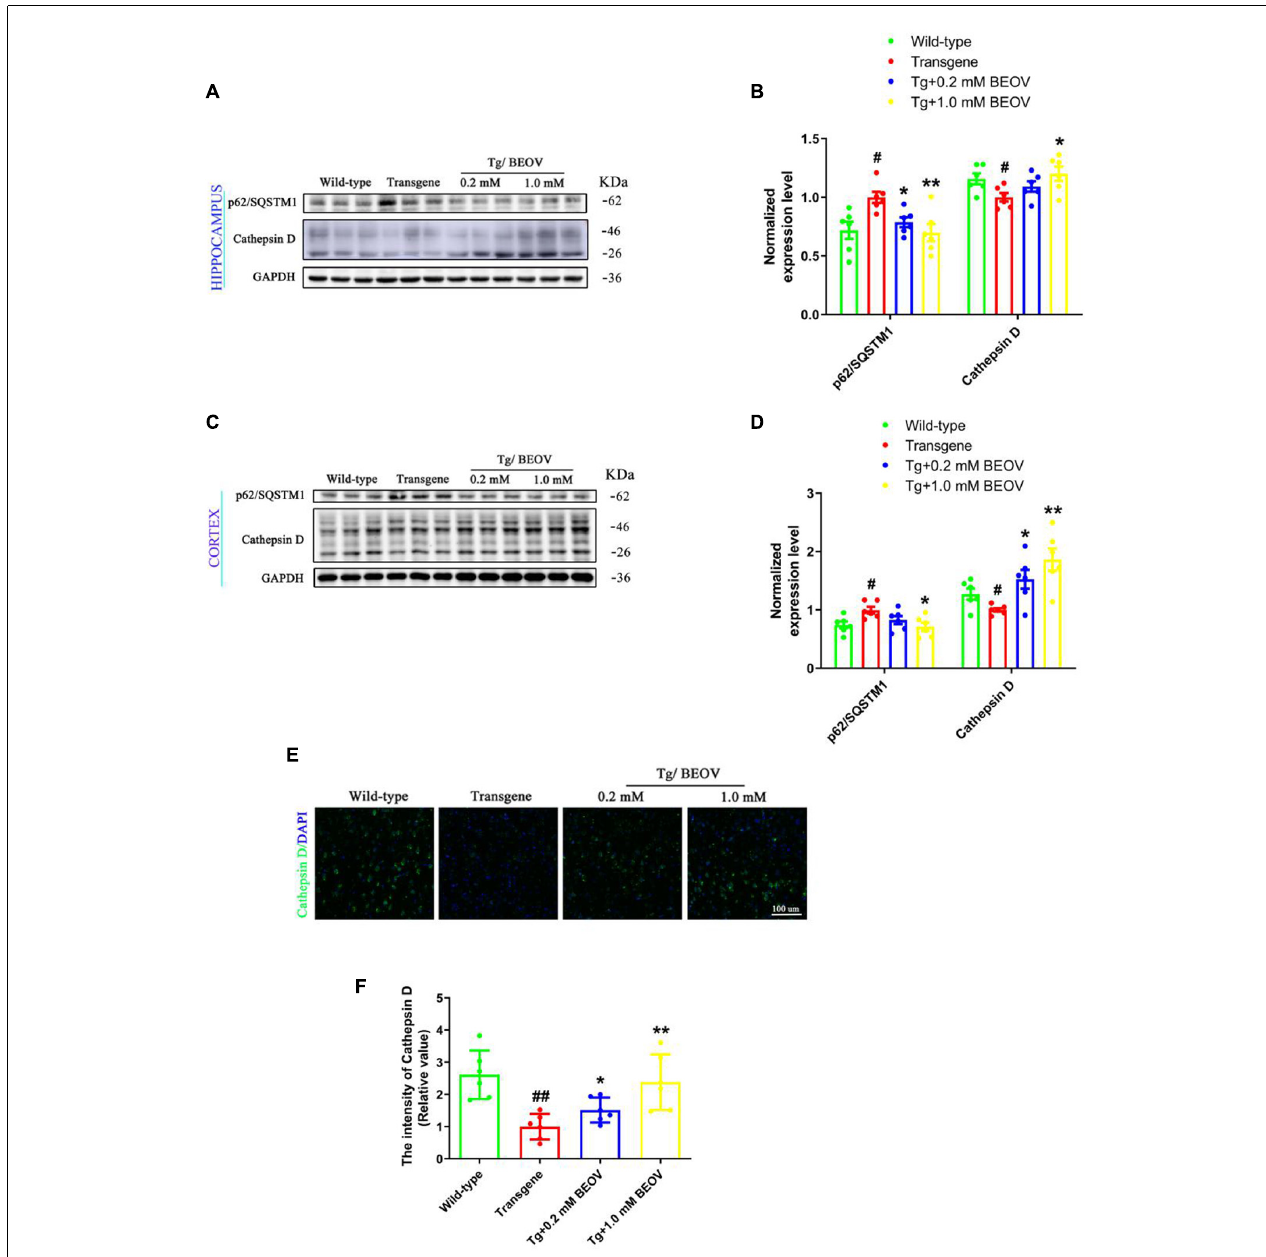
FIGURE 10 | BEOV reduced the p62 levels and increased the Cathepsin D levels. (A,C) Western blot analyses of p62/SQSTM1 and Cathepsin D levels in hippocampus and cortex of WT, APPSwe/PS1dE9, and BEOV-treated APPSwe/PS1dE9 mice. (B,D) Semi-quantification of p62/SQSTM1 and Cathepsin D in mouse hippocampus and cortex. Quantitative results were normalized against the levels of GAPDH. (E) Representative immunofluorescent images of Cathepsin D expression in the cortex. Scale bar: 100 µ m. (F) The staining intensity of Cathepsin D was quantified and six sections from different mice in each group were analyzed. # WT group vs. AD group; *AD + BEOV group vs. AD group. n = 6, three females and three males; # P < 0.05, ## P < 0.01, * P < 0.05 and ** P < 0.001,